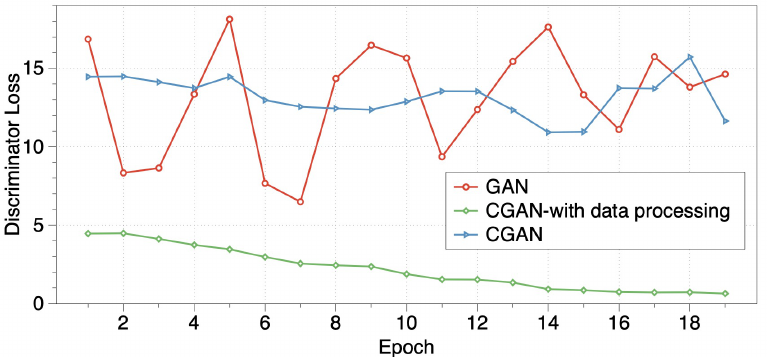
Figure 6. The effectiveness of data processing.